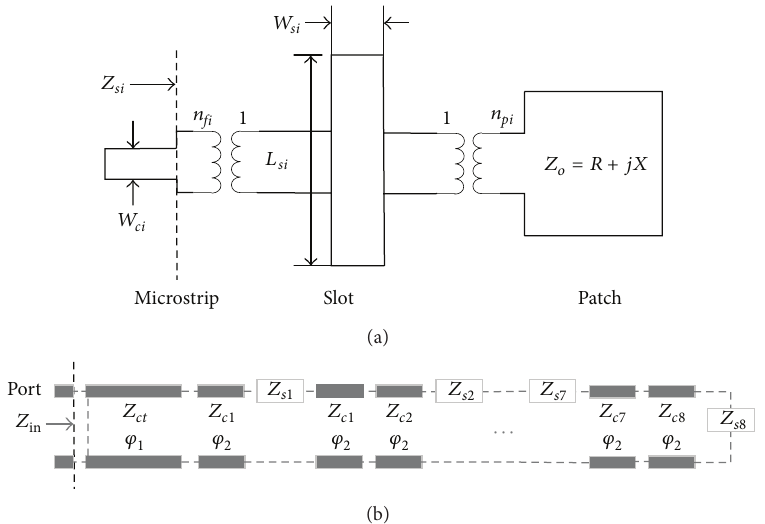
Figure 2: Transmission line model of the antenna. (a) Transmission line model of the slot coupling ( 𝑍 𝑠𝑖 ( 𝑖 = 1–8) express the equivalent impedance of the slot coupling; 𝑍 𝑜 expresses the equivalent impedance of the radiation patch). (b) Transmission line model of the microstrip expresses the input impedance of the port; 𝑍 𝑐𝑡 expresses the characteristic impedance of the transformation line for matching with ring ( 𝑍 in 50 Ω ; 𝑍 𝑐𝑖 ( 𝑖 = 1–8) express the characteristic impedance of the matching segments; 𝜑 𝑖 ( 𝑖 = 1, 2) are the phase delay of each matching segment).